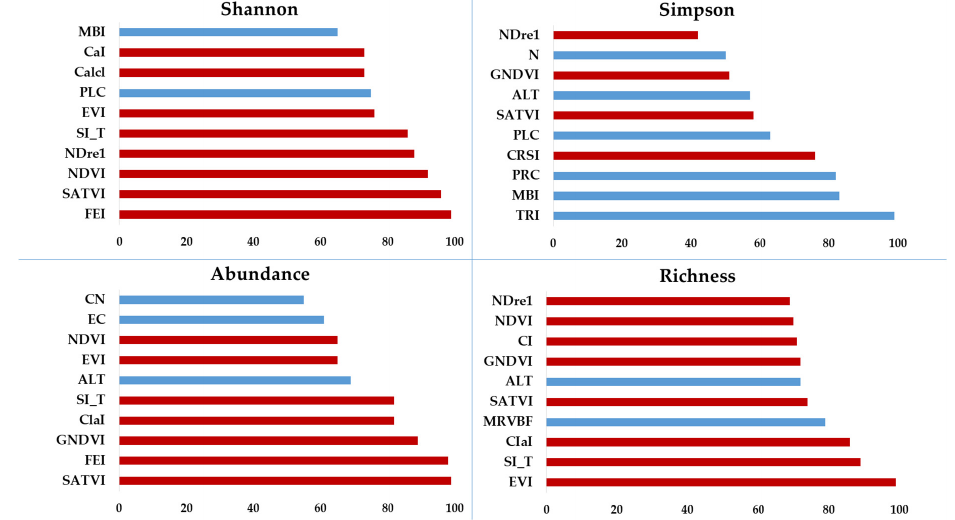
Figure 4. Ten of the most important variables in modeling and predicting the Simpson’s, Shannon’s, and richness’ indexes, as well as vegetation cover in February for RF models, based on remotely sensed and geodiversity variables . Remotely sensed variables are shown in red, and geodiversity variables are shown in blue.